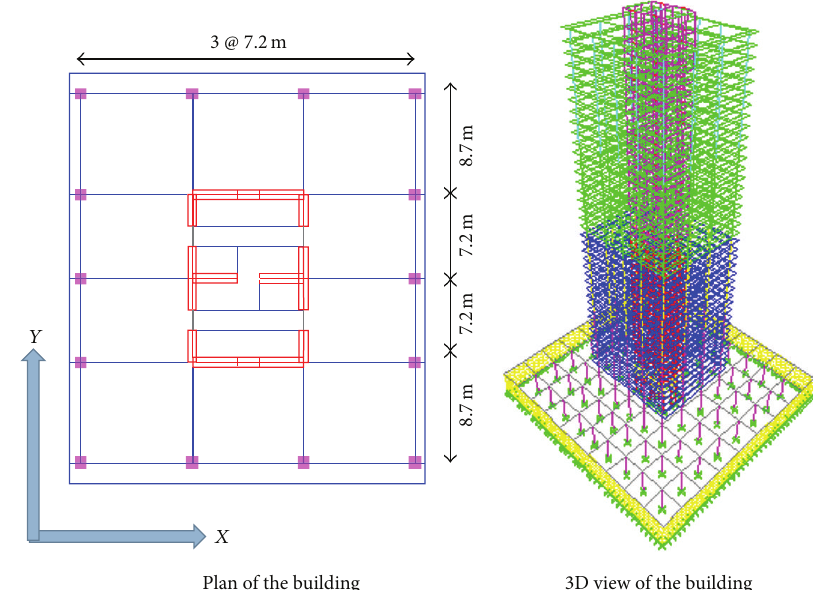
Figure 1: Plan and 3D model of the